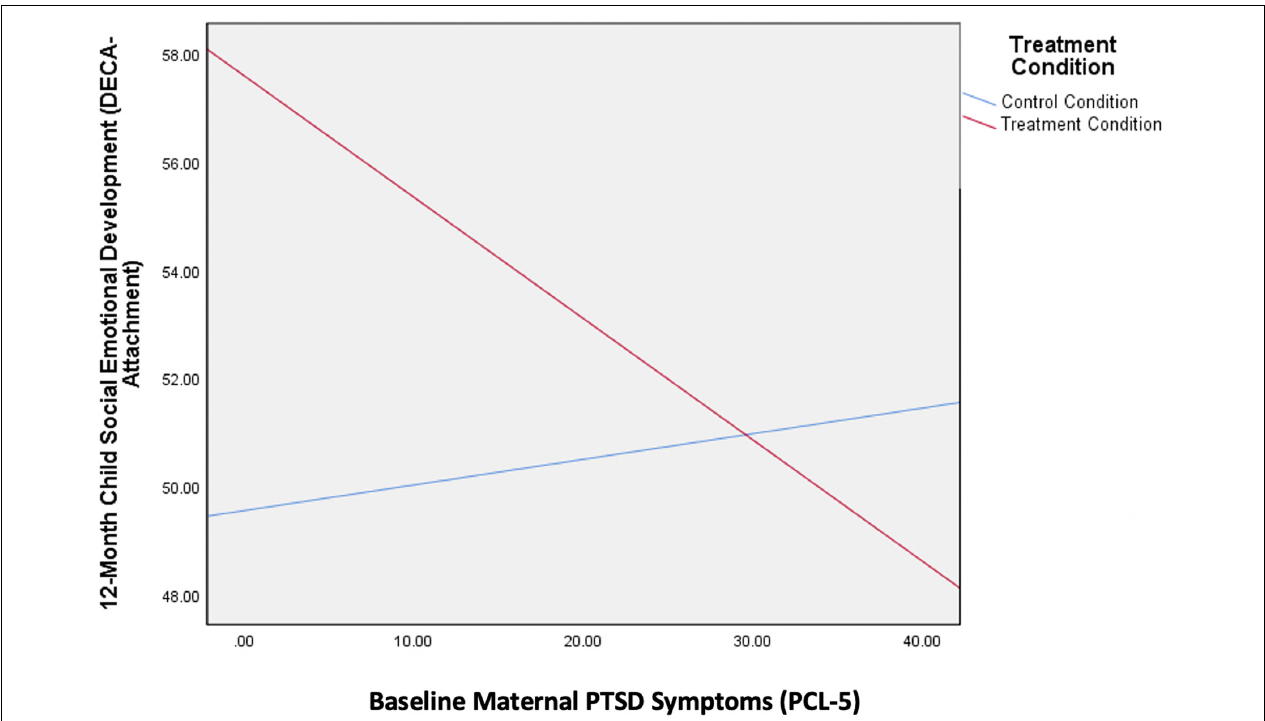
FIGURE 2 | Interaction between maternal PTSD symptom at baseline and treatment condition on child socioemotional development.